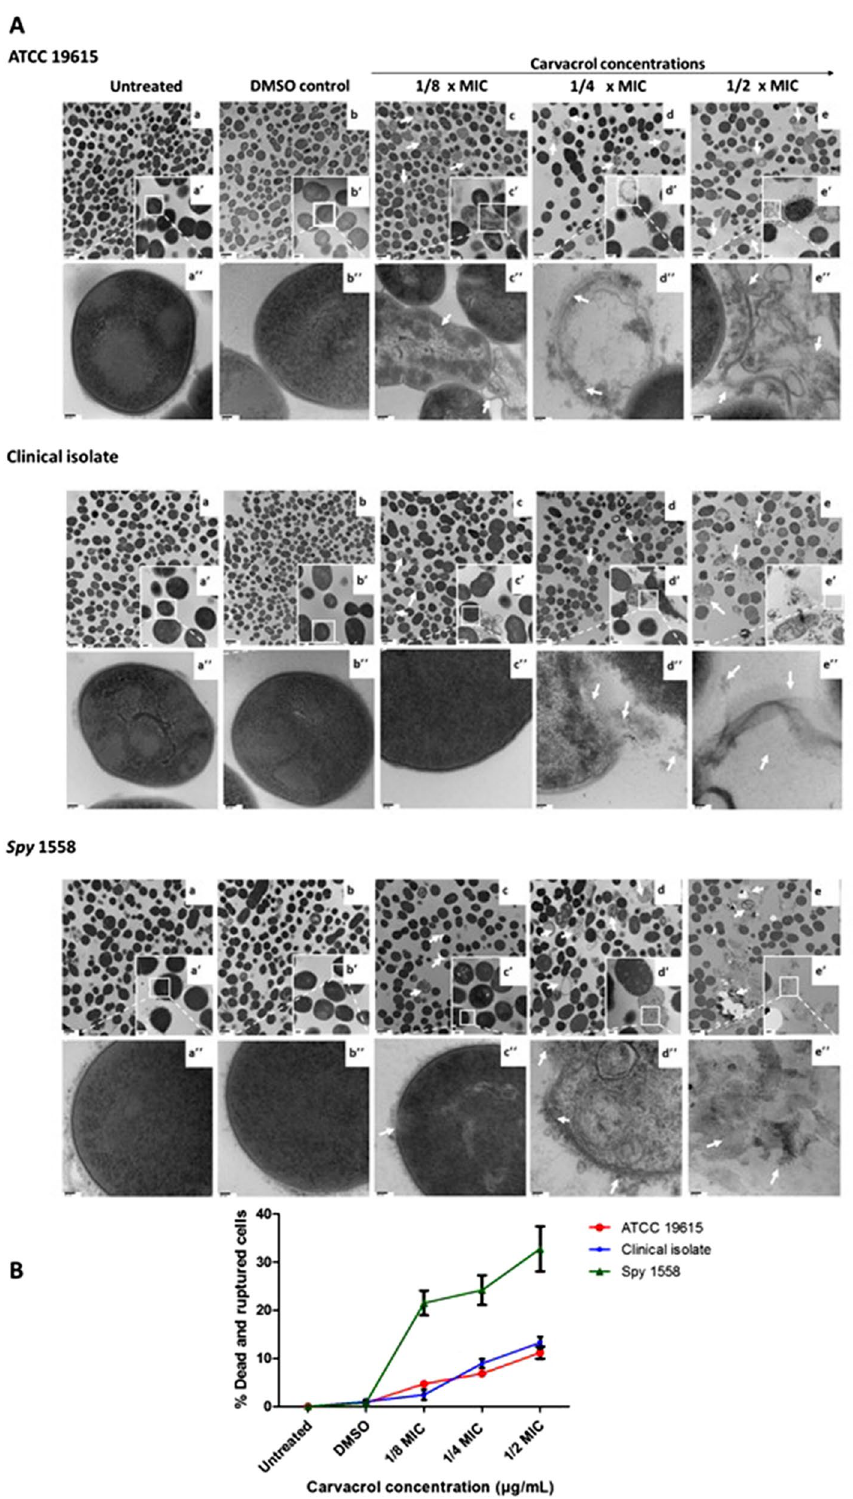
Figure 3. Transmission electron microscopic micrographs of three strains of Streptococcus pyogenes treated with or without exposure to carvacrol. ( A ) Cell morphology of vehicle control (DMSO) (b,b ′ ,b ′′ ), carvacrol at 1/8 × MIC (c,c ′ ,c ′′ ), carvacrol at ¼ × MIC (d,d ′ ,d ′′ ), and carvacrol at ½ × MIC (e,e ′ ,e ′′ ) were compared with untreated bacterial (a,a ′ ,a ′′ ) in BHI media. The exponential phase of S. pyogenes Spy 1558 cells was treated with different concentrations of carvacrol for 16 h. Images were taken at magnifications of × 10,000, × 50,000 and × 100,000 for a,b,c,d,e , a ′ ,b ′ ,c ′ ,d ′ ,e ′ ’ and a ′′ ,b ′′ ,c ′′ ,d ′′ ,e ′′ , respectively. Arrows indicate dead cell morphologies. MIC minimum inhibitory concentration, BHI brain heart infusion. ( B ) Percentage of carvacrol-induced morphological damages determined by TEM. An average of 200 cells from two independent experiments were analyzed per each treatment. Morphological changes were quantified as the percentage of ruptured and dead cells to the total